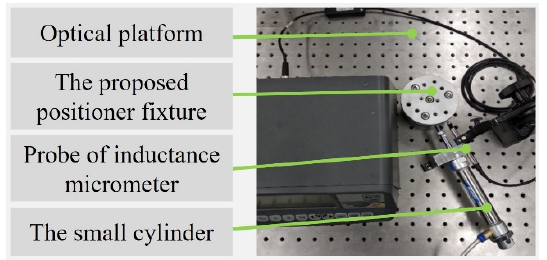
Figure 8. Experimental setup for the stiffness measurement.